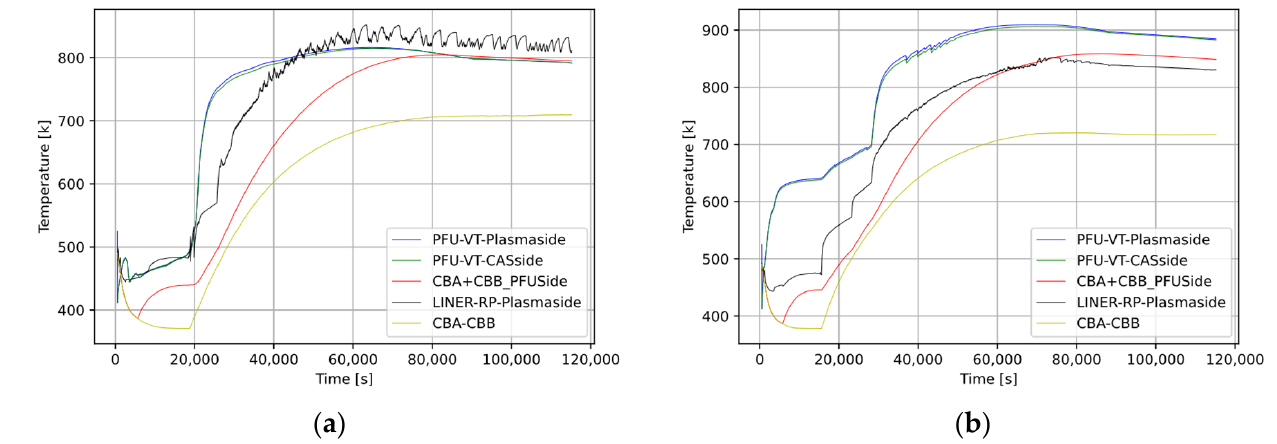
Figure 14. Long-term temperature pattern in divertor HTS object of break PIE1 ( a ) and PIE2 ( b ) cases.